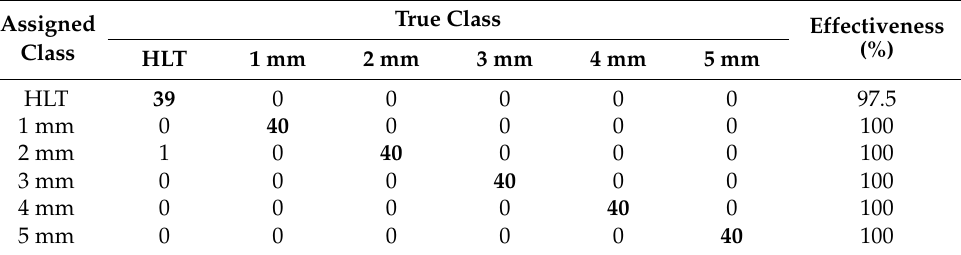
Table 6. Effectiveness percentage of the proposed methodology (confusion matrix) when analyzing all considered bearing conditions for a VFD power supply at 5